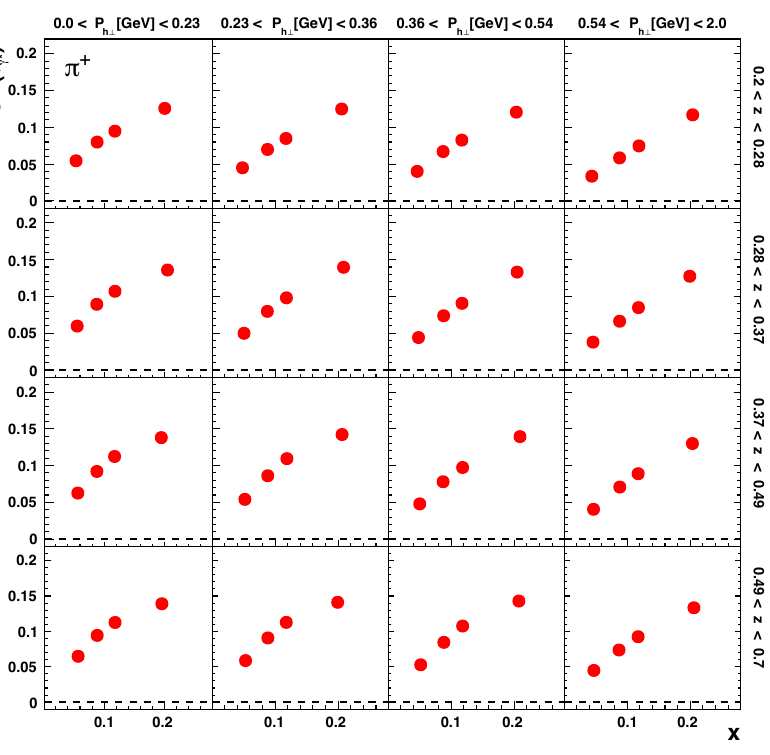
Figure 38 . Average sin θ γ ∗ as a function of x in bins of z and P h ⊥ in the same three-dimensional binning used for the analysis of azimuthal asymmetries of charged mesons (using here π + data as an